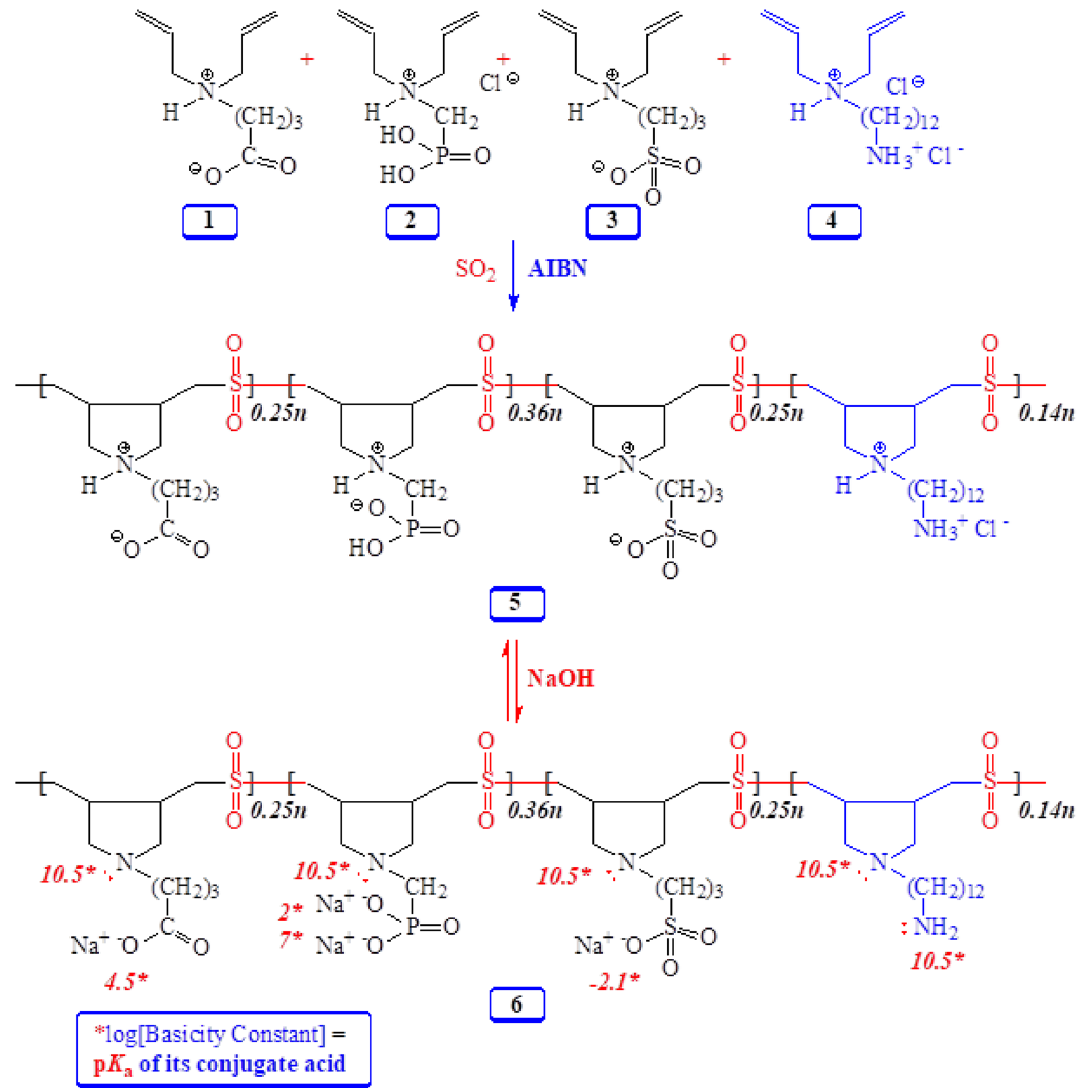
Figure 1. Cycloplymerization of monomers 1 – 4 and SO 2 leading to PP 5